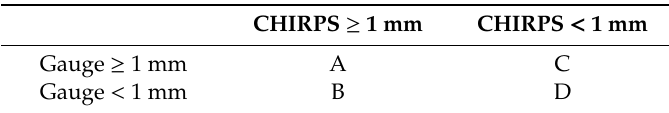
Table 1. Contingency table for comparing CHIRPS satellite-based rainfall estimates and rain gauge observations (daily rainfall threshold used is 1 mm). The four possibilities are true positive (A), false positive (B), false negative (C) and true negative (D).